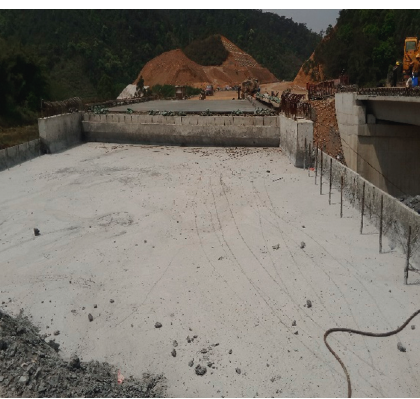
Figure 1: Foamed mixture lightweight soil as highway embank- ment